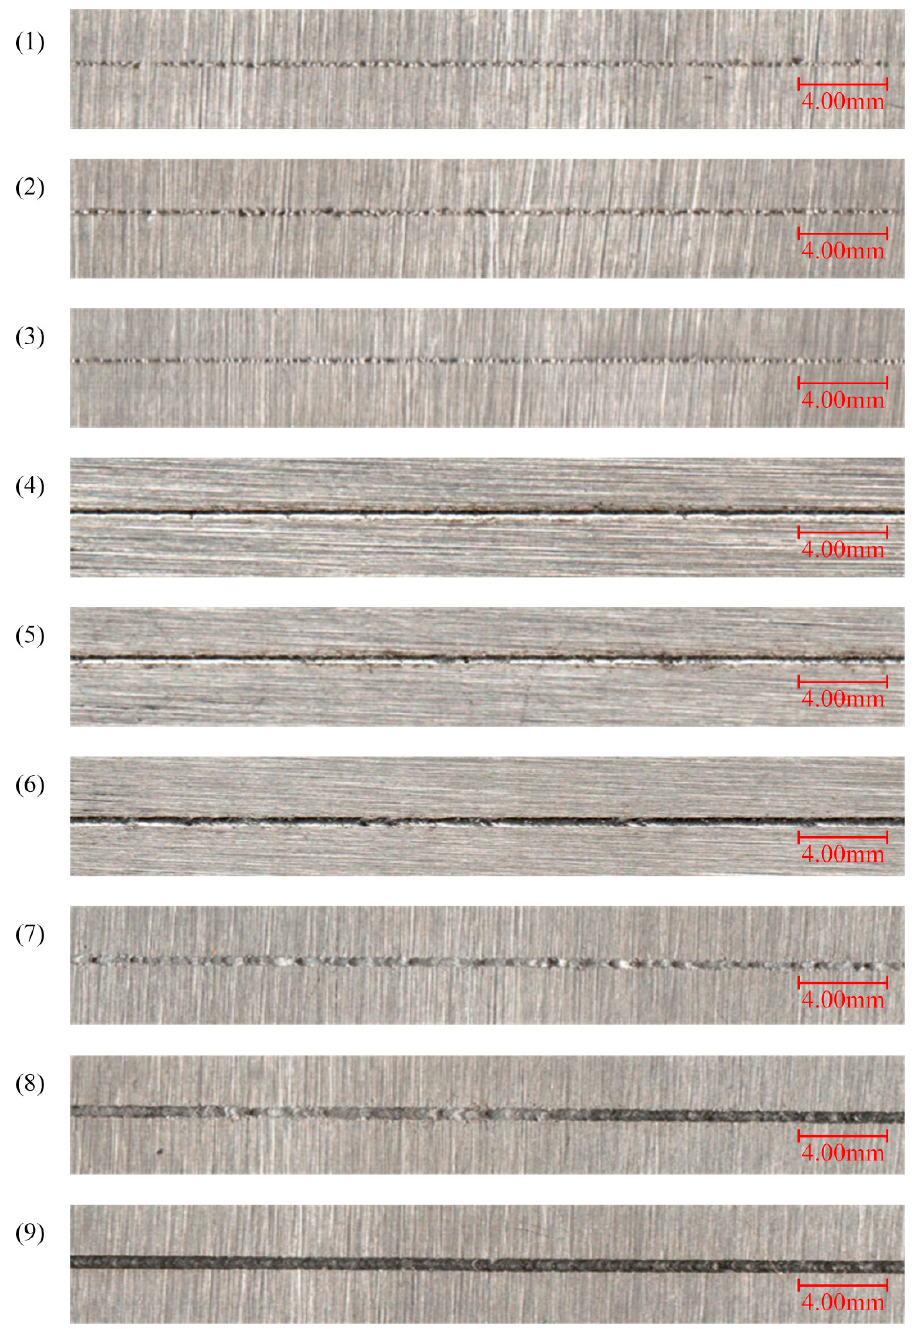
Figure 3. The morphology of the single tracks of 9 groups process parameters.